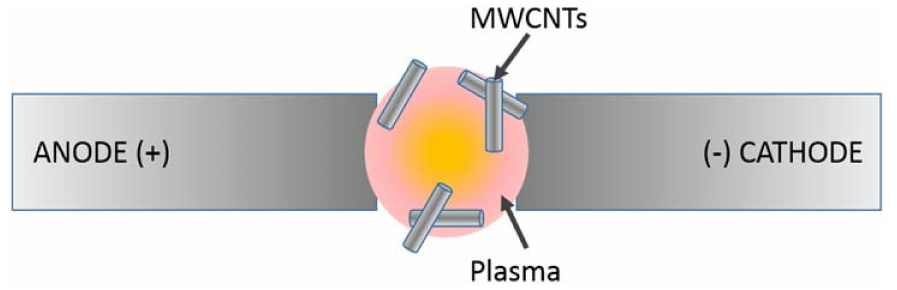
Figure 12. The MWCNT synthesized by the arc discharge